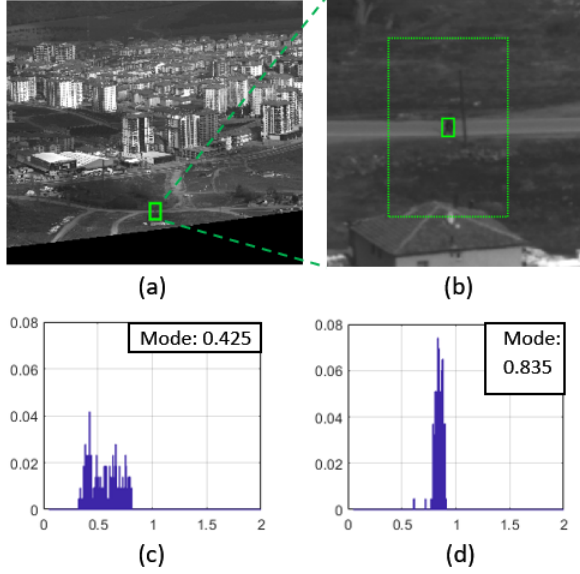
Figure 4. Surviving Detection and Distribution of Reflectance Ratios: (a) Zoom-Out Image Patch, (b) Candidate Object & Surroundings, (c) Distribution of the Candidate, (d) Distribution of the